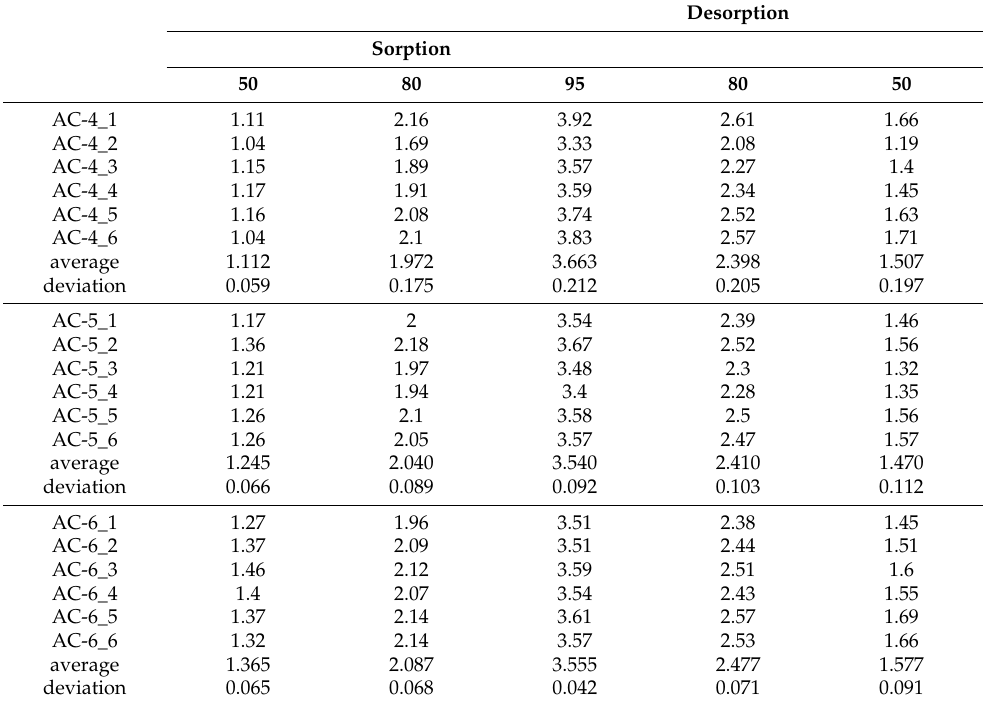
Table 6. Results of the sorption in sulfuric acid